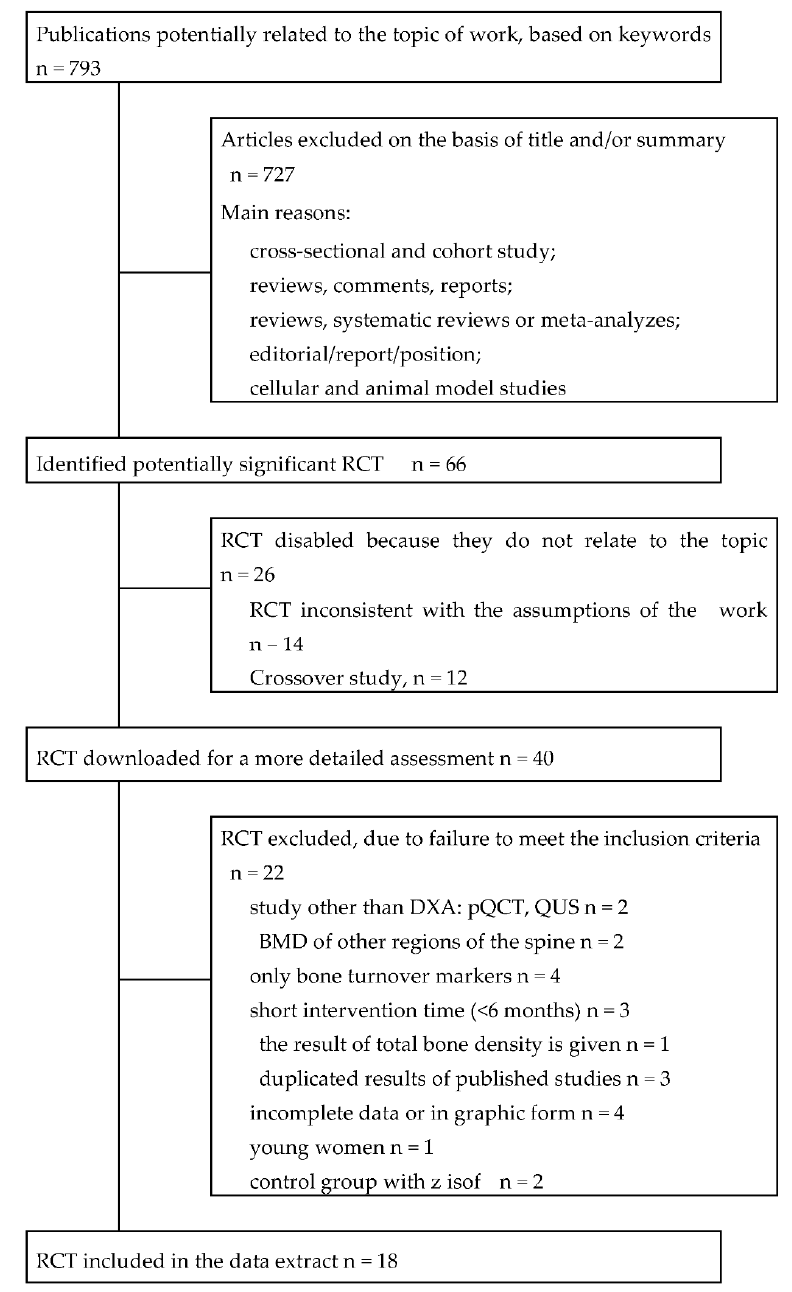
Figure 1. Literature search and research selection process. Abbreviations: RCT, randomized, con- trolled clinical trial; DXA, dual-energy X-ray absorptiometry; QCT, quantitative computer tomog- raphy; QUS, quantitative ultrasonography; BMD, bone mineral density.